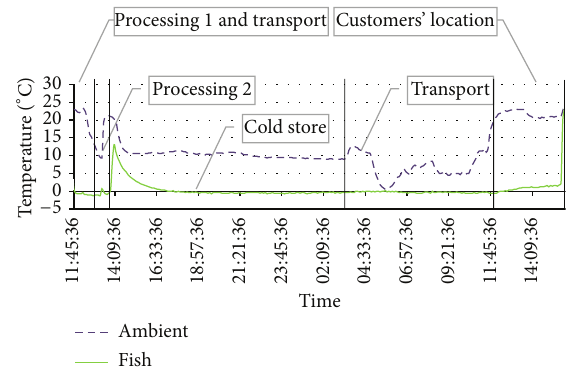
Figure 12: Temperature graph (Seˇca, 7.6.2012—Ljubljana,